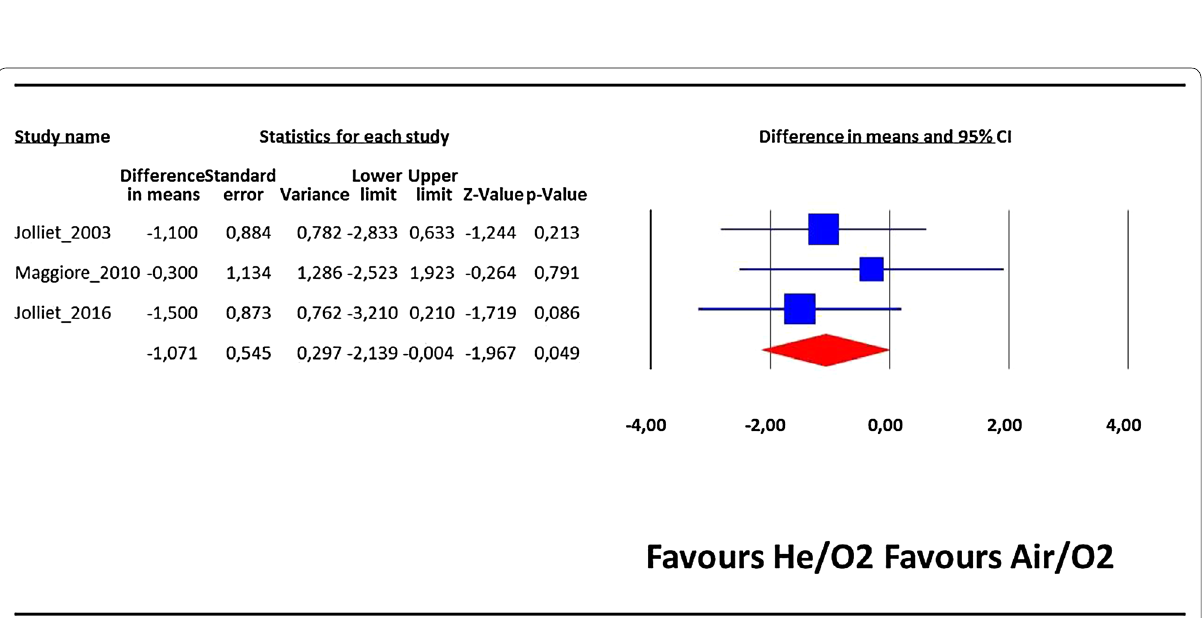
Fig. 4 Rate of NIV complications. Blue squares represent odds ratios (ORs) in individual trials, while the red diamond represents the combined overall effects. I 2 test for heterogeneity: 0.02%